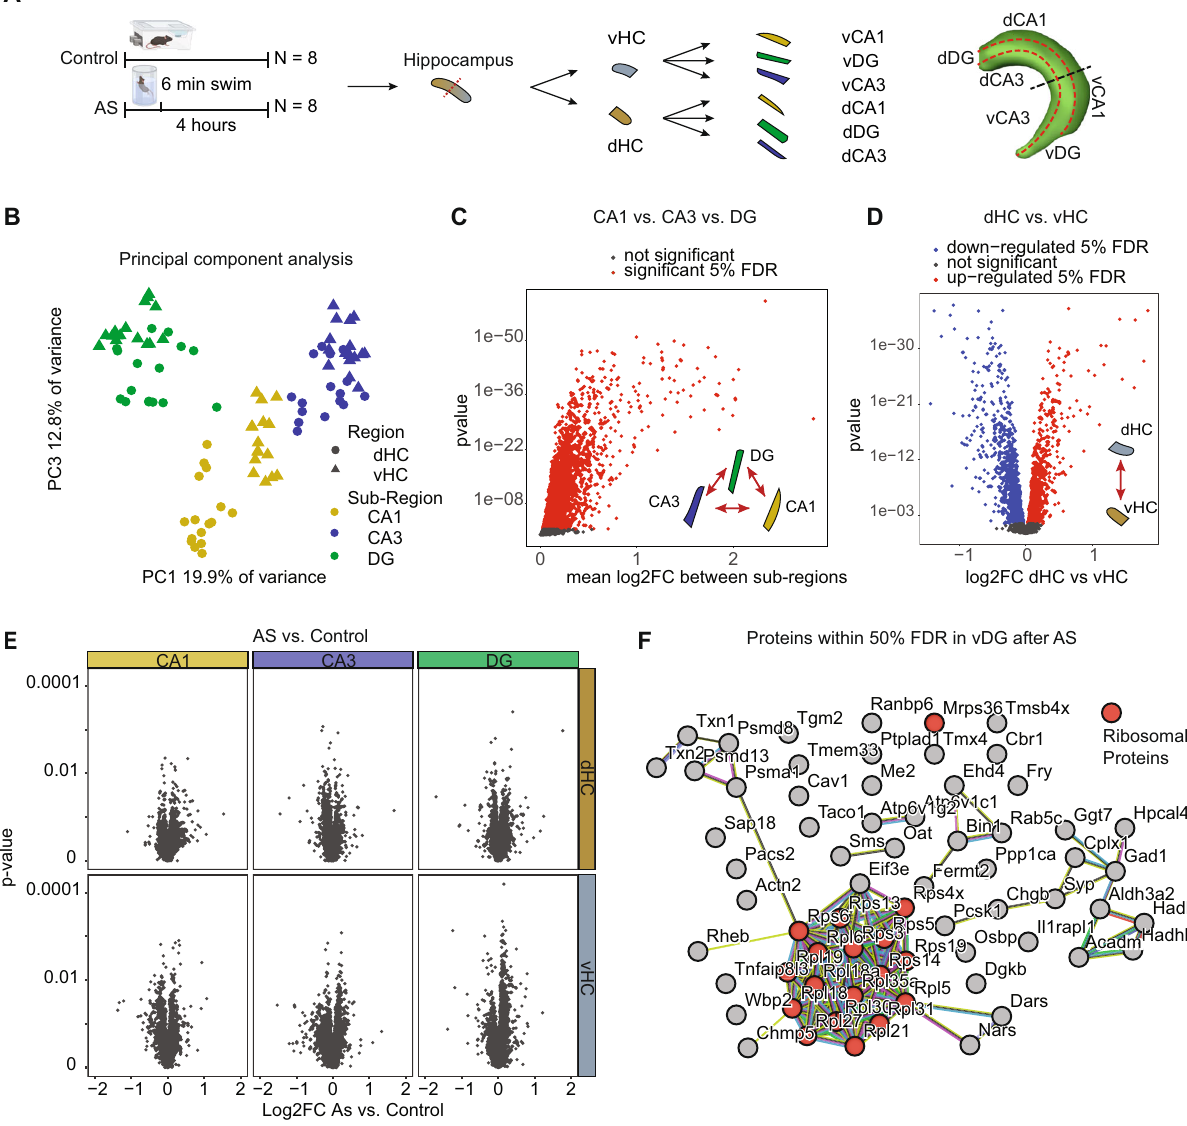
Fig. 7 The effects of acute stress (AS) on the proteome of CA1, CA3 and DG in the dorsal hippocampus (dHC) and ventral hippocampus (vHC). A Experimental design and tissue collection approach. B Principal component (PC) analysis of all samples. The fi rst component resolves sub-regional differences, whereas the 3rd further resolves dorsal-ventral differences. We did not fi nd any component that resolves stress. C Statistical results for ANOVA subregion * region within animals (omitting stress vs homecage as variable). Many proteins have signi fi cant (red, within 5% false discovery rate (FDR)) sub-regional expression differences at baseline. D Same analysis as in ( C ). Many proteins show signi fi cant dorsoventral expression differences at baseline (red, upregulated in dHC 5% FDR, blue downregulated in dHC 5% FDR). E Volcano plots showing the log2 fold change and statistical results of the 2 group comparisons homecage vs swim of proteins 4 h after a 6 min exposure to AS in all regions and sub-regions. No proteins are within the 5% FDR. F protein-protein interaction network of stress sensitive proteins in the vDG (50% FDR). Experiments performed in male